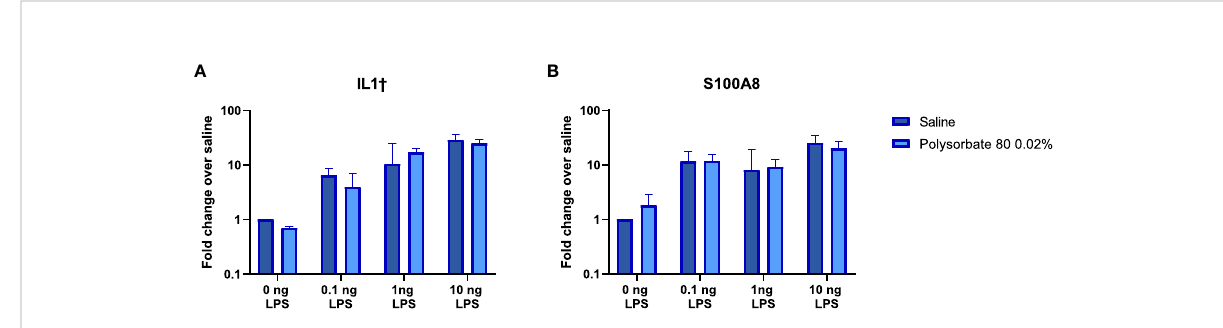
FIGURE 4 Polysorbate 80 does not mask detection of LPS in vivo . Mice were injected subcutaneously with increasing concentrations of LPS in the presence of saline (blue bars) or 0.02% w/w polysorbate 80 (light blue bars) (n=3/group). Results are shown as the fold change in IL-1 b (A) and S100A8 (B) mRNA in local skin 6 hours post injection relative to mice that received the same volume of saline. Data is presented as the geometric mean and geometric standard deviation.